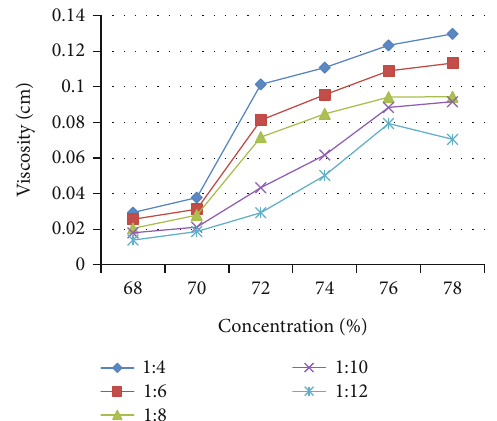
Figure 6: Relationship curve between plastic viscosity coe ffi cient and concentration of mixed slurry with di ff erent cement tailing ratios.